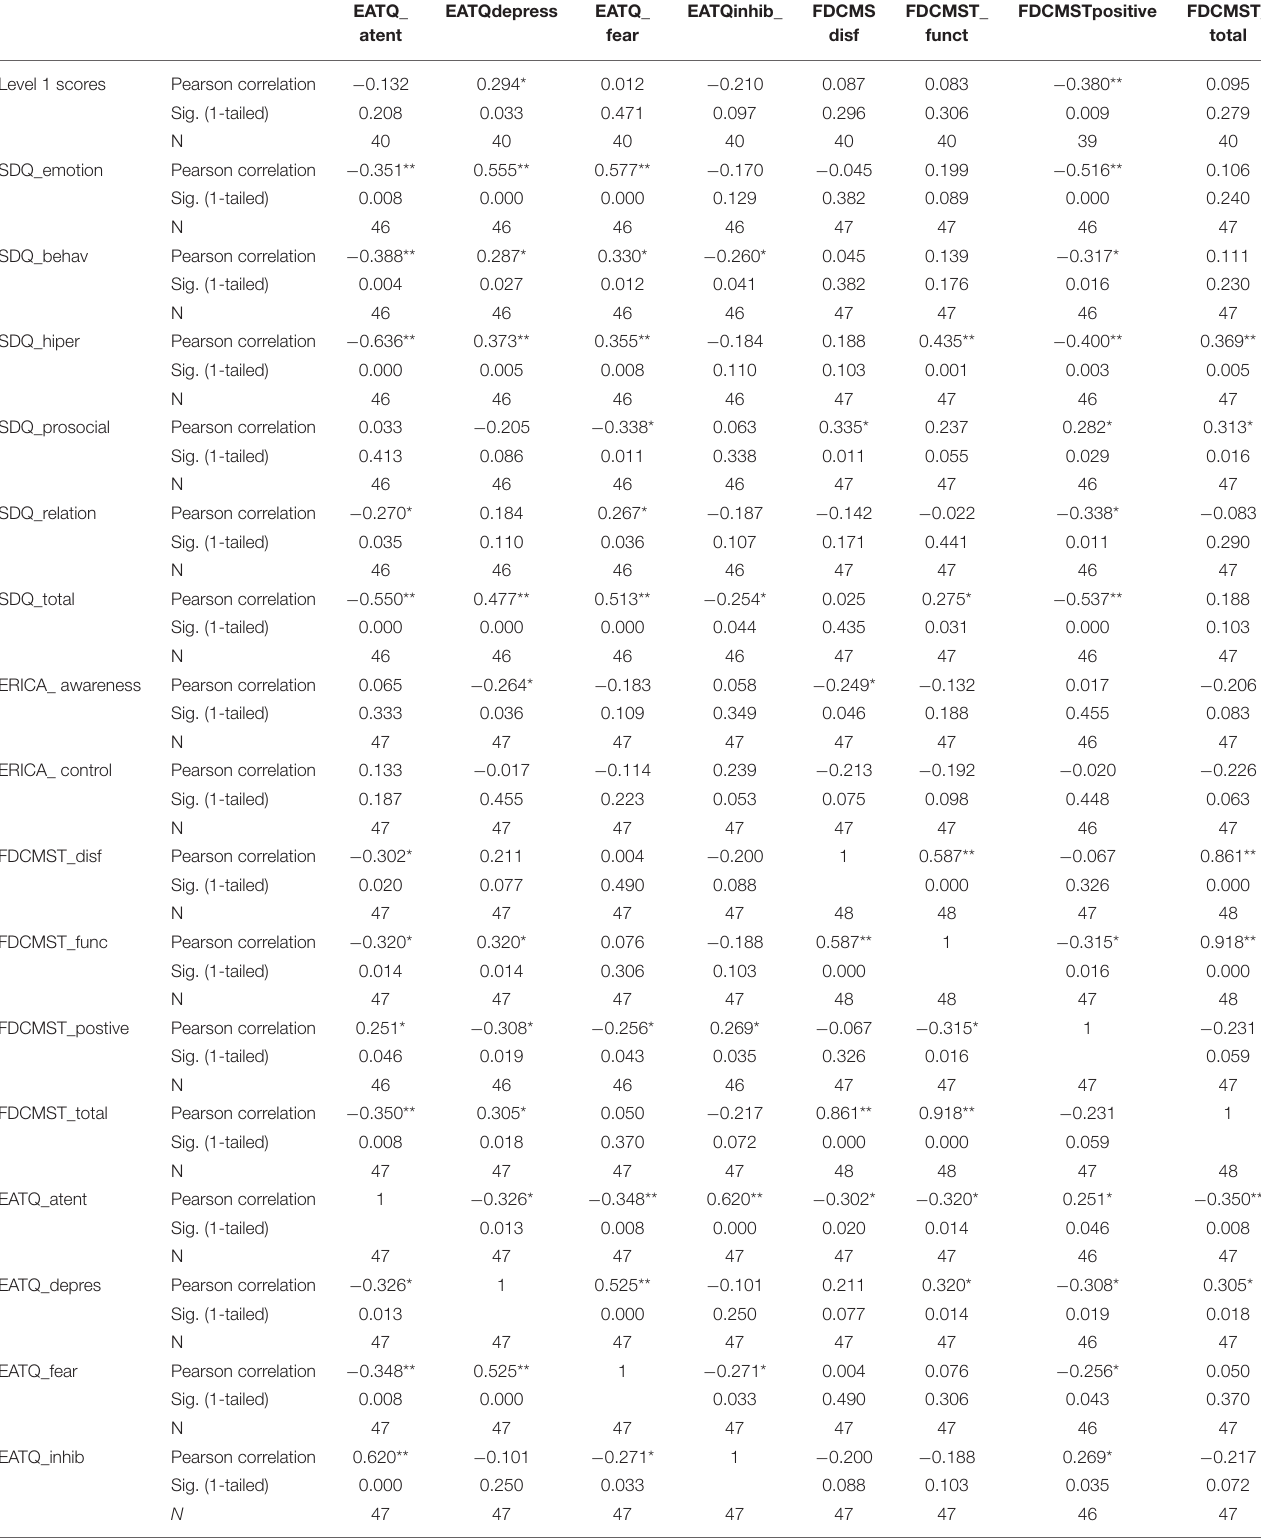
TABLE 3B | Correlation analysis for Level 1